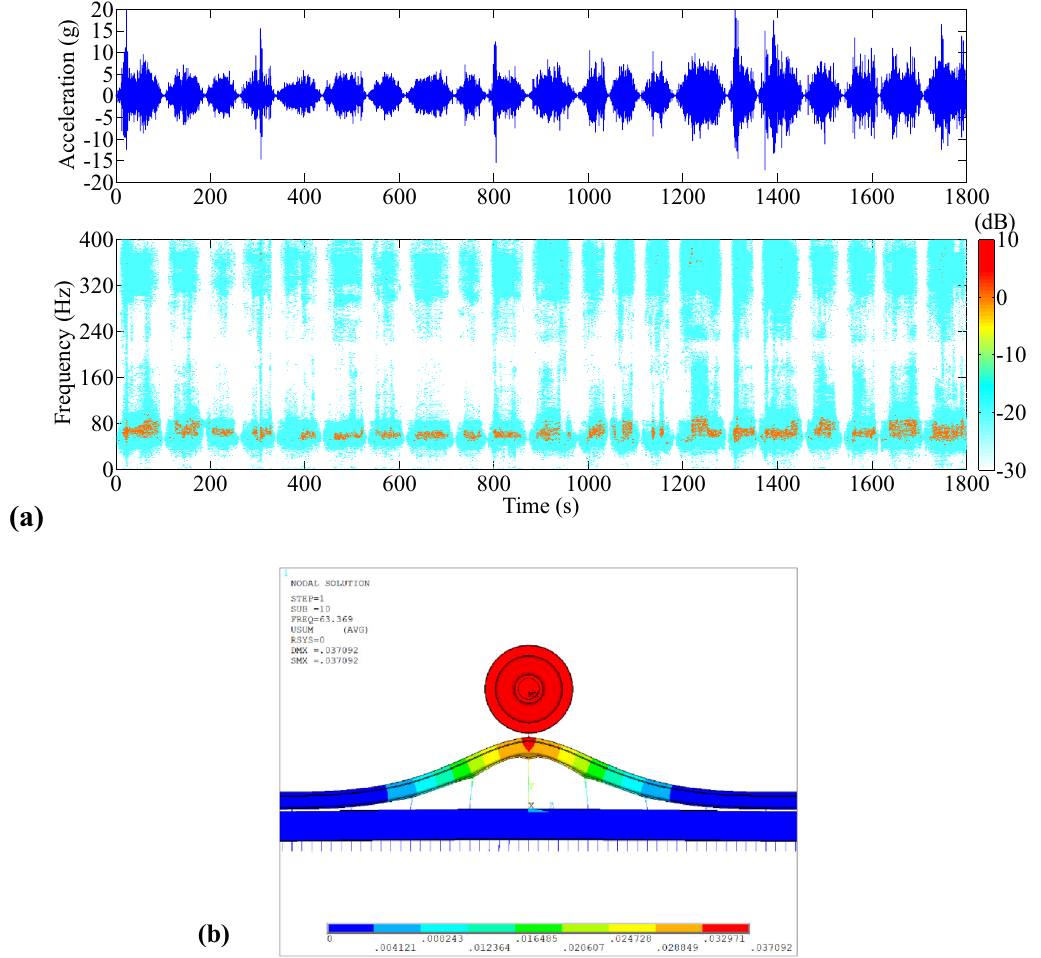
Fig. 15 a Time history and time–frequency spectrum of axle box vertical acceleration of the tested train running on the metro line for a single trip. The dominant frequencies of the axle box vertical acceleration range from 50 to 80 Hz, which are induced by the P2 resonance. b Mode shape of the P2 resonance with frequency of 63 Hz of monolithic concrete bed with DTVI2 fastener, obtained by finite element